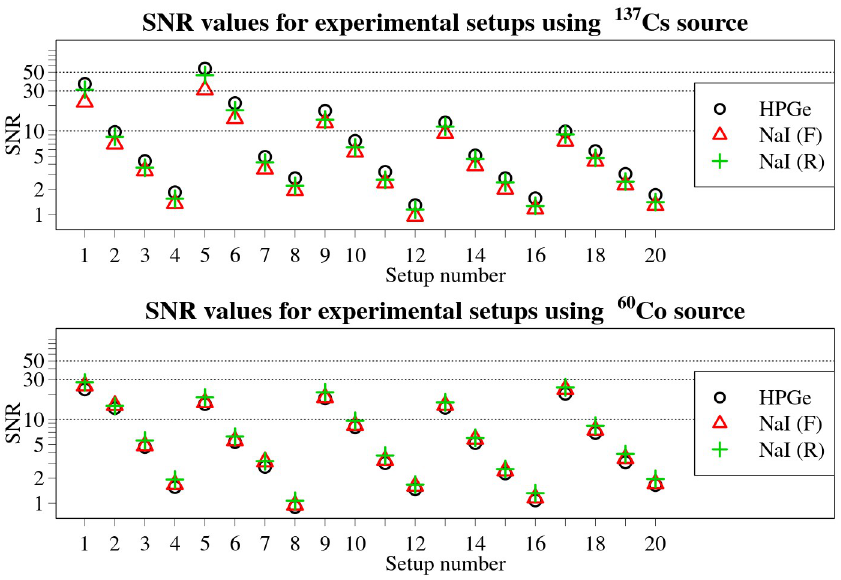
Fig 9. Calculated SNRs for all experimental set-ups and detector combinations for the two radionuclides used. Black circles mark values for HPGe detector, red triangles—front NaI(Tl) and green crosses—rear NaI(Tl) SNR values. Dotted horizontal lines mark SNR values of 10, 30 and 50. The SNR axis is